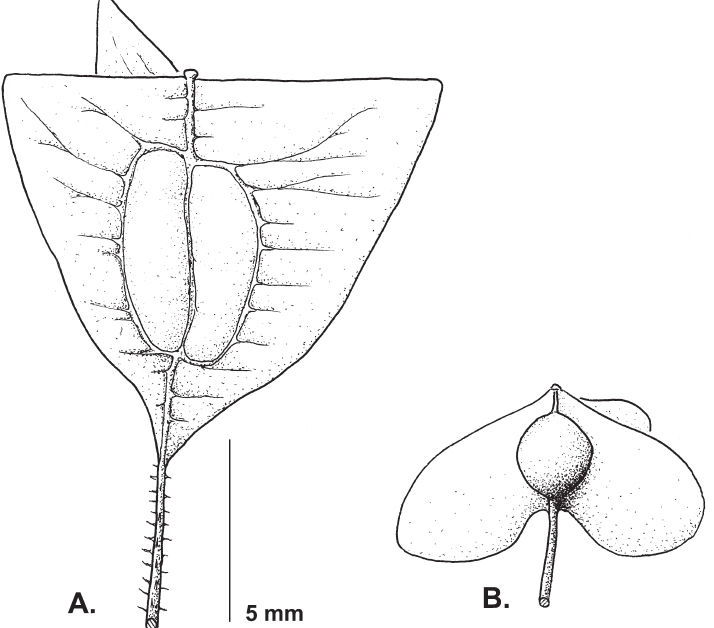
Fig. 64. Mature fruit from the types of A . B. wengeri C.E.C.Fisch. B . B. surculigera . Drawn by Rebecca Camfield. A from Wenger 324 (K); B from Kurz s.n.